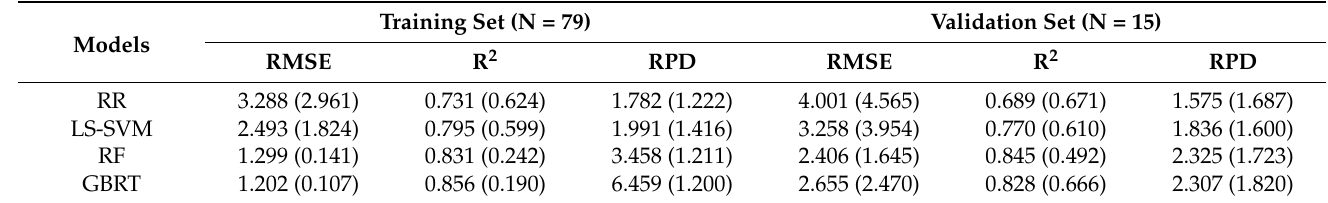
Table 3. Evaluation results of SOM estimation based on conventionally averaged covariates in terms of RMSE, R 2 , and RPD, after 20 iterations with the same training and validation sets as the XWT features. Average and standard deviations are shown within parenthesis.